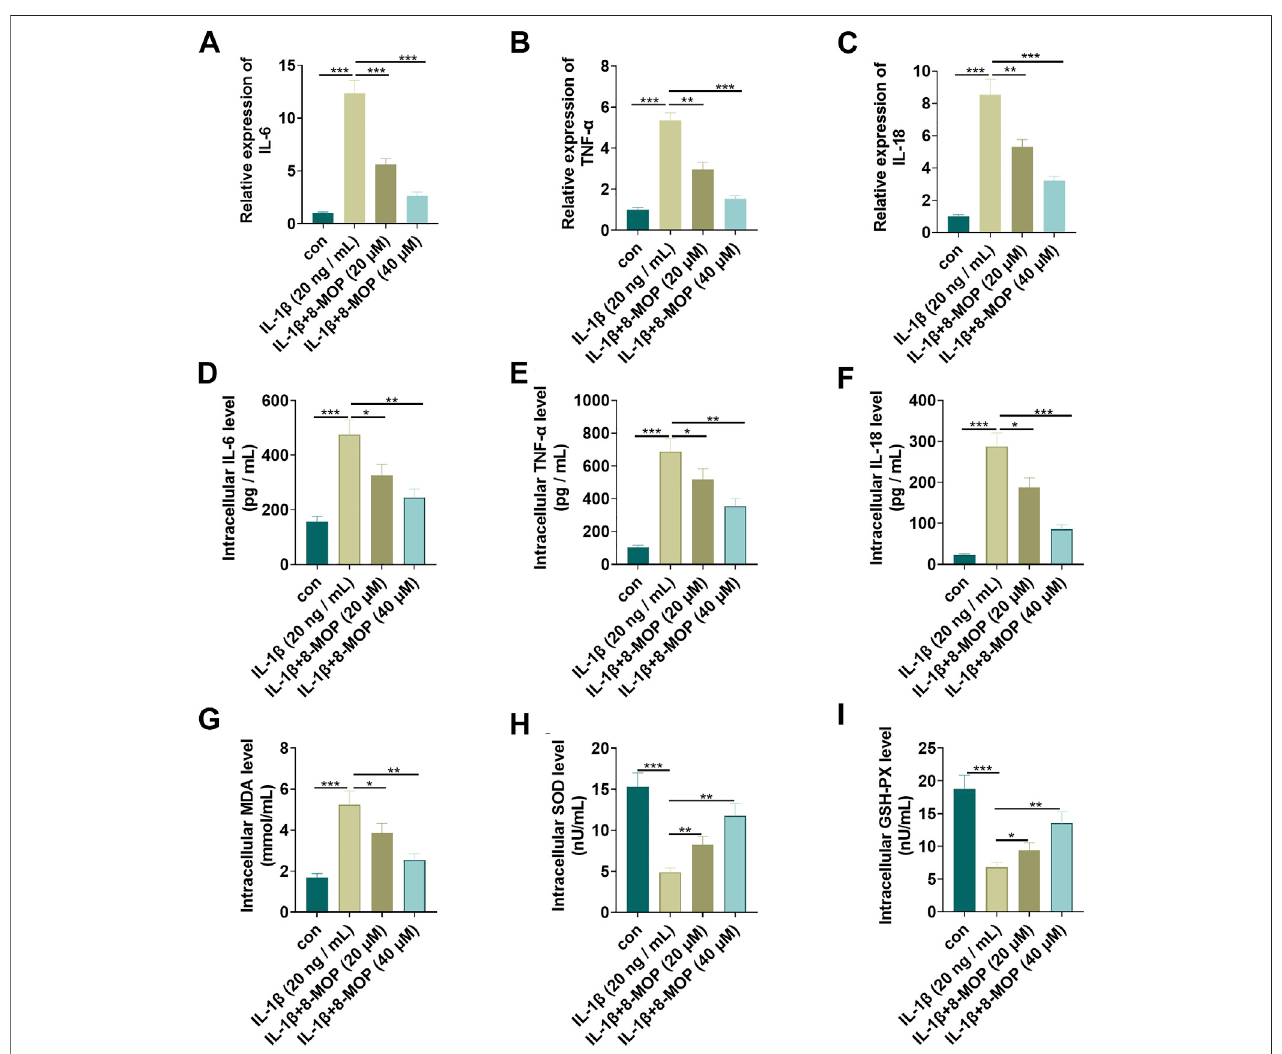
FIGURE 2 | 8-MOP weakened IL-1 β -mediated in fl ammatory and oxidative stress responses. Rat chondrocytes were treated with IL-1 β (20 ng/ml) and/or 8-MOP (20 and 40 µM) for 24 h. (A – F) . The levels of in fl ammatory cytokines (IL-6, TNF- α , and IL-18) were detected by qRT-PCR and ELISA. (G – I) : The oxidative stress factors (MDA, SOD, and GSH-PX) in chondrocytes were measured by the MDA, SOD, and GSH-PX detection kits. * p < 0.05, ** p < 0.01, *** p < 0.001. ( n (cid:1) 3).